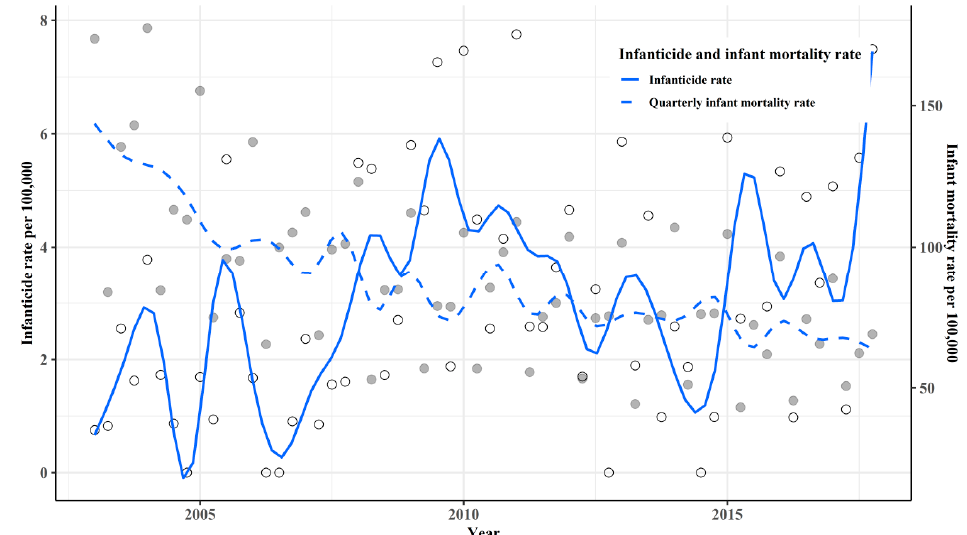
Figure 1. Time trend of infanticide and quarterly infant mortality rate per 100,000 from 2003 to 2017. The points colored in gray indicate infant mortality rate by quarter and the white point indicate the infanticide rate by quarter.